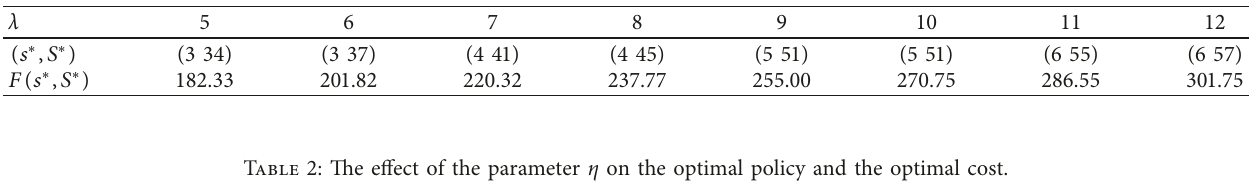
Figure 6: Effect of p on mean waiting time W q for various impatient rate ξ . Table 1: The effect of the parameter λ on the optimal policy and the optimal cost.